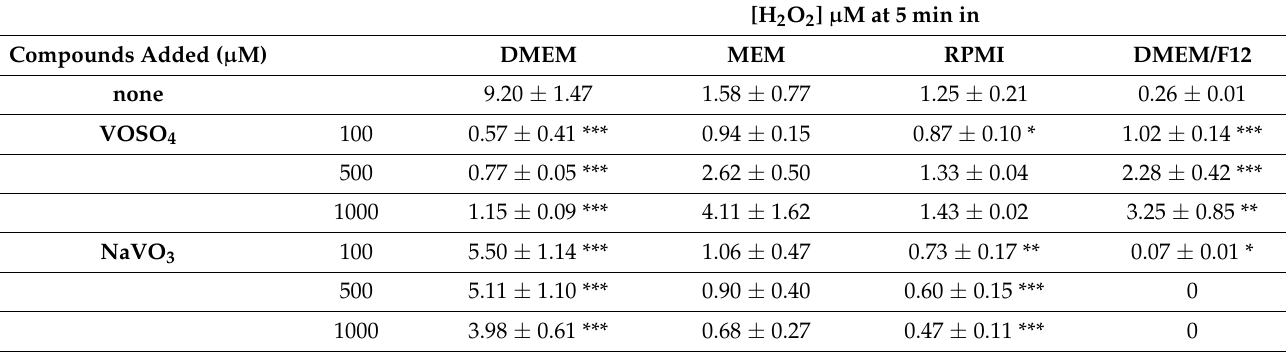
Table 2. H 2 O 2 in different cell culture media exposed to NaVO 3 and VOSO 4